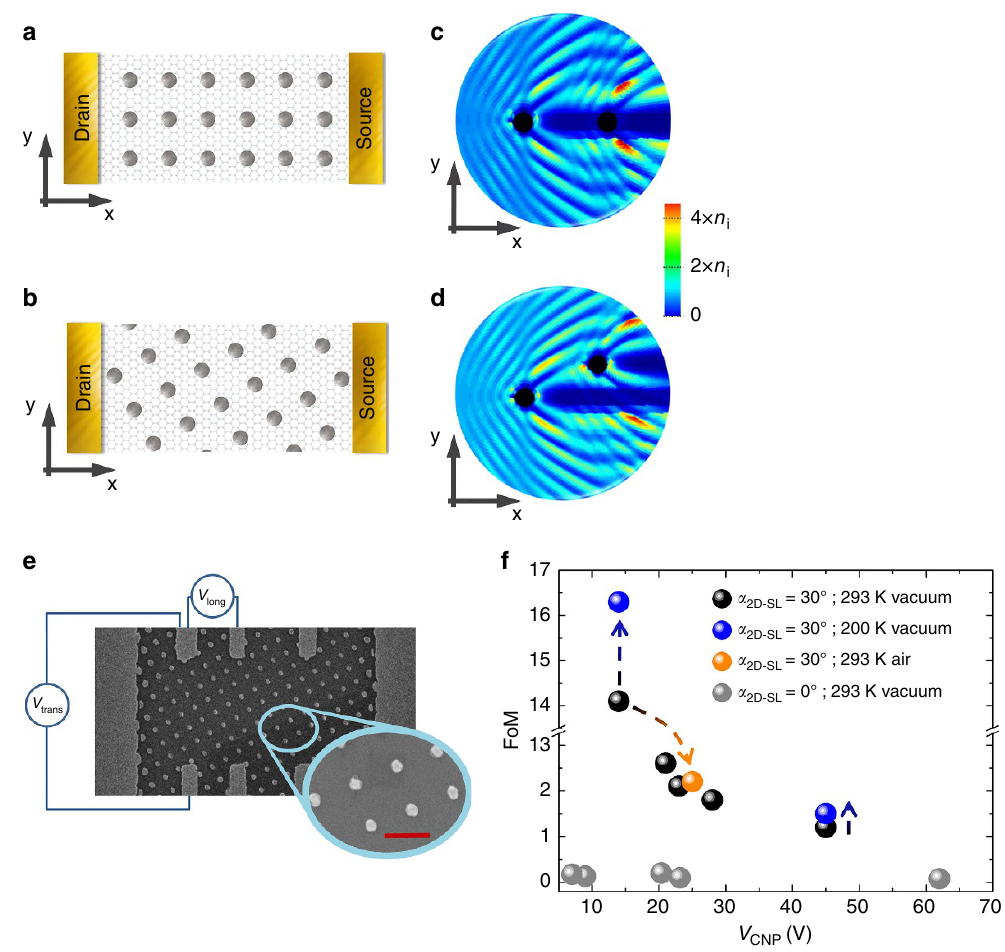
Figure 1 | Cascaded Mie scattering in square potential 2D-SL. Not-to-scale schematic of a top-view of graphene with ( a ) an aligned ( a 2D (cid:2) SL ¼ 0 (cid:2) ) and ( b ) a canted 2D-SL ( a 2D (cid:2) SL ¼ 30 (cid:2) ) on top contacted by source- and drain-electrodes (current flowing along x axis). The grey discs indicate the potential- defining 13–15 metal dots on top of the graphene. In real samples the 2D-SL periodicity exceeds the graphene unit-cell size by orders of magnitude. Relativistic quantum-mechanical calculation of electronic density distribution for cascaded Mie scattering on two ( c ) aligned and ( d ) canted potentials (black, 100nm diameter). In both cases the electronic wave-function is incident from the left along the x axis (Fermi-energy 20meV). For the canted arrangement an asymmetric re-distribution is found consisting of a pile-up of electronic (that is, charge carrier) density on one side (here top). This implies the generation of a transverse voltage along the y axis. The scale bar is normalized to the incoming electronic density n i of 1 (cid:3) 10 11 cm (cid:2) 2 . ( e ) A scanning electron image of graphene sample with a Ti 2D-SL rotated by a 2D (cid:2) SL ¼ 30 (cid:2) relative the direction of the traversing current ( I b ). The 2D-SL has a 350nm periodicity with dot diameter of 100nm. Schematically indicated measurement of transverse and longitudinal voltage, V trans and V long , respectively. Zoom: Rotated 2D-SL. Scale bar, 350nm. ( f ) Standard FoM 21 for transverse signals analysis in electronic devices for aligned (grey symbols, a 2D (cid:2) SL ¼ 0 (cid:2) ) and canted ( a 2D (cid:2) SL ¼ 30 (cid:2) ) 2D-SL samples studied with different charge-neutrality points ( V CNP ). Strikingly, for all aligned 2D-SLs basically no transversal signal is observed, whereas for all canted arrangements a finite signal is detected. The FoM decreases with increasing V CNP . Dashed arrows indicate change in FoM for samples on decreasing temperature change (black-blue) or exposure to ambient environment